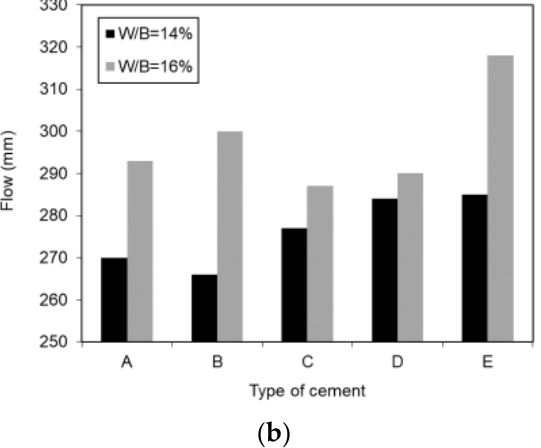
Figure 6. Effect of HRWRA. ( a ) HRWRA addition ratio. ( b ) Mortar flow.